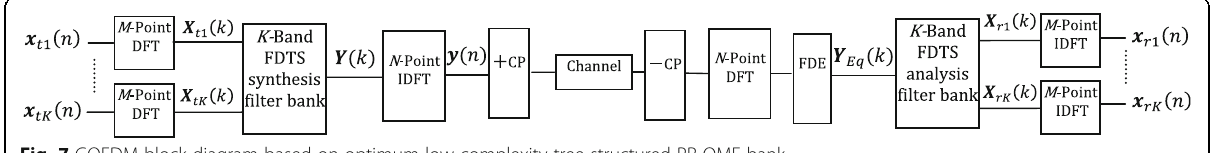
Total number of